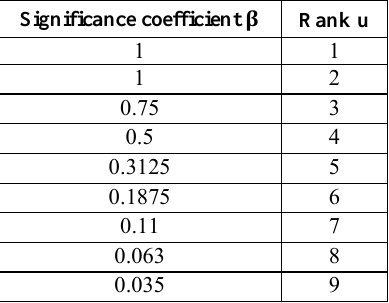
Table 2. Significance coefficient Values for ranks 1-9 Significance